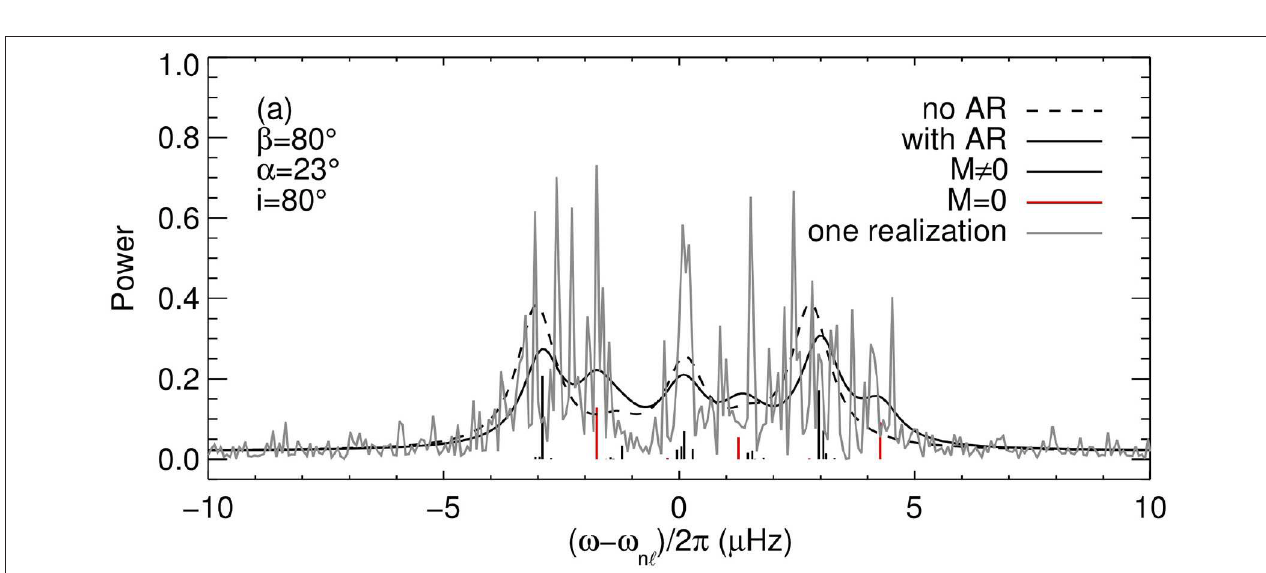
FIGURE 7 | A realization of the power spectrum of an ℓ = 2 multiplet (gray) and its expectation value (black solid curve, also shown in Figure 4D ). The observation duration is 6 months and the signal-to-noise ratio is 50. The dashed black curve shows the expectation value of the pure rotational spectrum.